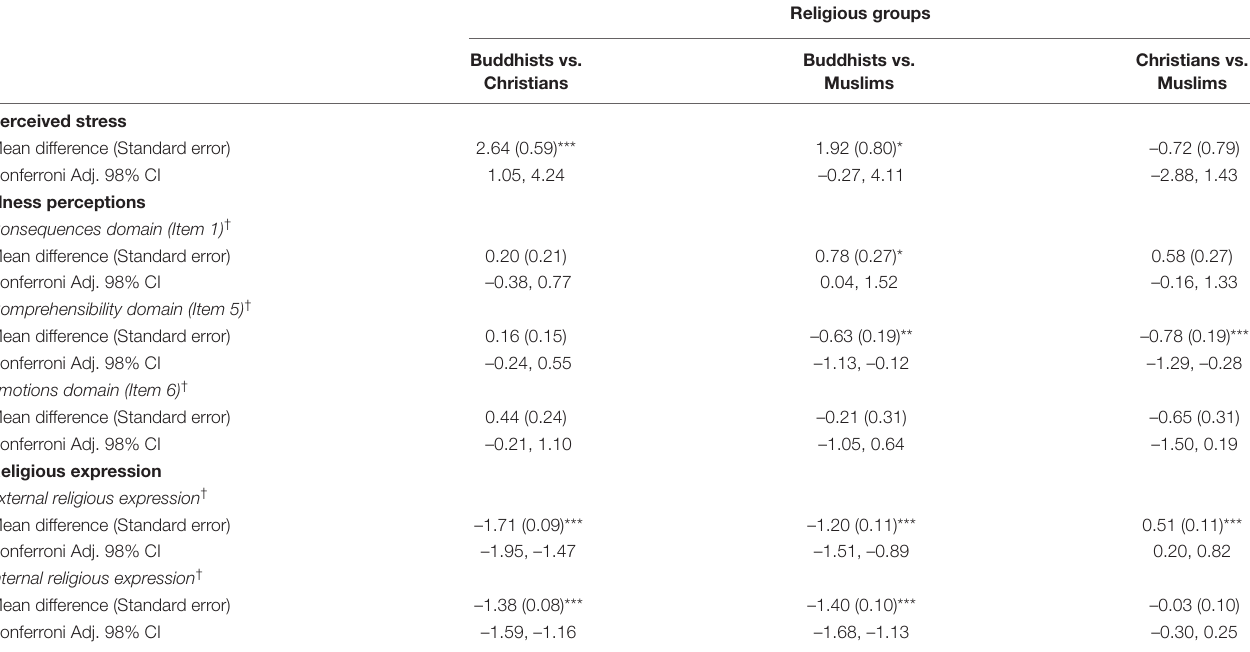
TABLE 2 | Post hoc comparison on perceived stress, illness perception, and religious expression by religious